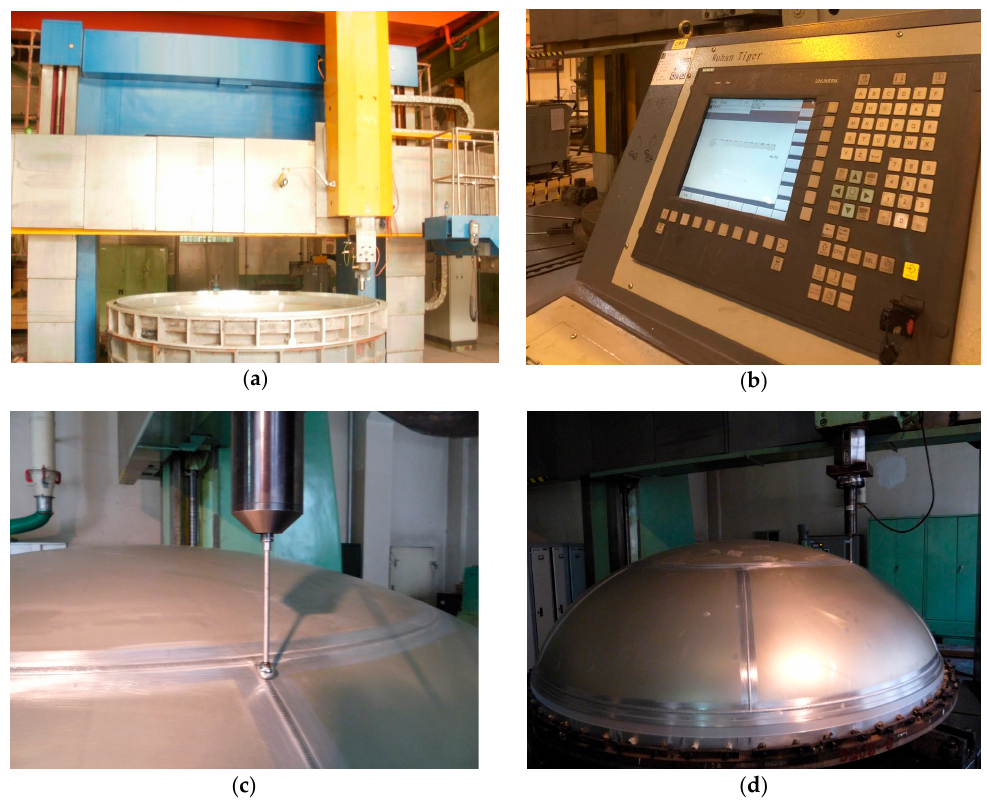
Figure 5. The measuring system and measured 3D free-form surface: ( a ) vertical lathes; ( b ) computer numerical control (CNC) system; ( c ) scanning probe; ( d ) half-ellipsoidal measured part. Table 1. Detailed technical characteristics of the measuring system.